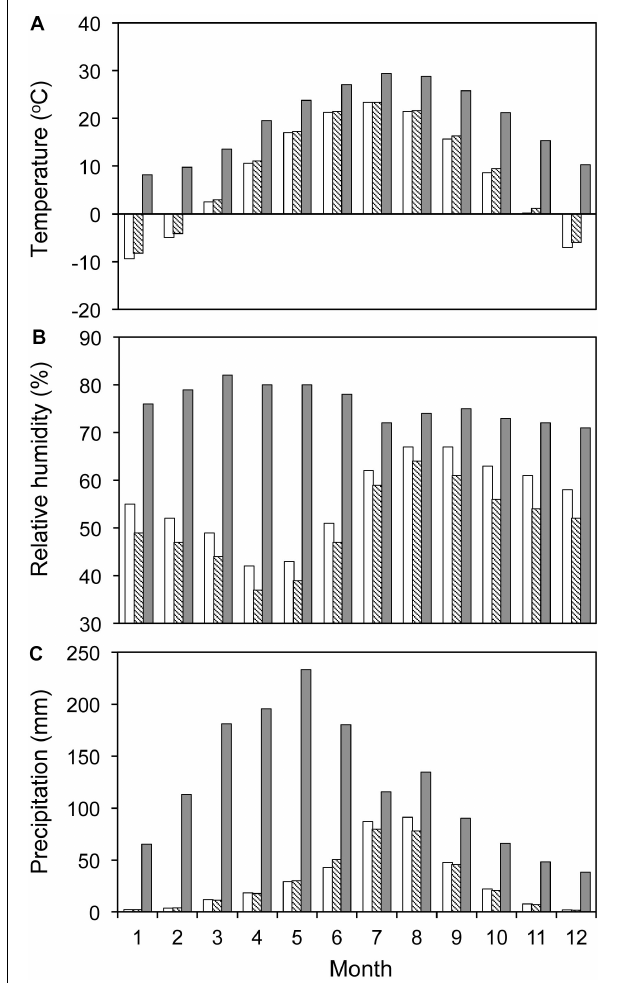
FIGURE 3 | Meteorological data near the study sites. (A) Temperature ( ◦ C), (B) relative humidity (%), and (C) annual precipitation (mm). Gray-filled bars show the data from the Ganzhou Meteorological Observatory near the DH site, white-filled bars and black diagonal-filled bars show the data from the Meteorological Observatories of Yulin and Hengshan near the MDW site,